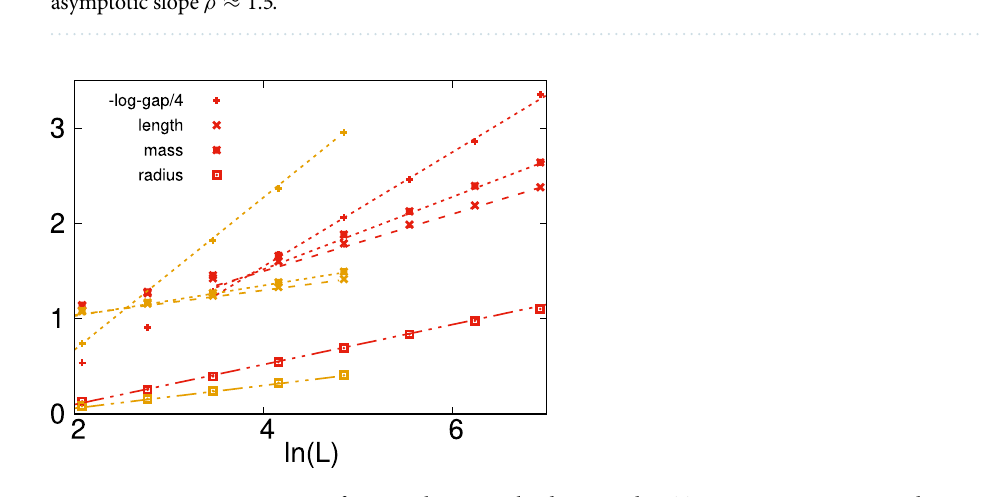
Figure 8. Average parameters of energy clusters in the d = 2 random TIM at �θ = 1 , corresponding to θ = 2.6784 and h 0 = 14.56 (red symbols) and in the d = 3 model at �θ = 1.3695 , i.e. θ = 3.9 and h 0 = 49.4 , (yellow symbols) as a function of the logarithm of the size of the system. Minus log-gap −[ ln (ε) ] av with asymptotic straight lines with slopes z ≈ 2.4 ( d = 2 ) and z ≈ 3.2 ( d = 3 ); the linear extension [ ℓ ] av with asymptotic slopes (cid:31) ≈ 0.30 ( d = 2 ) and (cid:31) ≈ 0.13 ( d = 3 ); the mass [ µ ] av with asymptotic slopes σ ≈ 0.38 ( d = 2 ) and σ ≈ 0.16 ( d = 3 ) and the radius of gyration [ R g ] av with asymptotic slopes ρ ≈ 0.21 ( d = 2 ) and ρ ≈ 0.12 ( d = 3